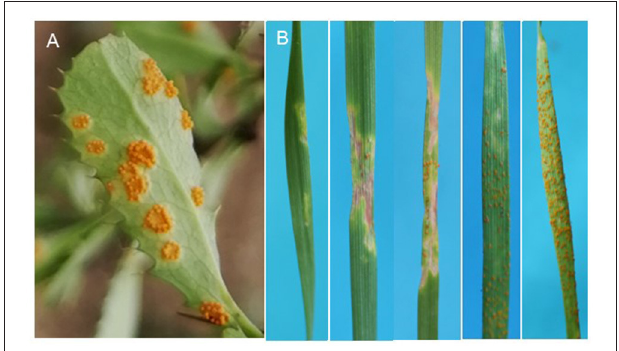
FIGURE 2 | Different infection types on leaves of wheat cv. Mingxian 169 after inoculation with aeciospores from aecial samples collected from naturally rusted barberry. (A) A leaf sample showing aecia produced on barberry ( Berberis diaphana ). (B) Infection types on leaves of wheat cv. Mingxian 169 after inoculation with aeciospores of aecial